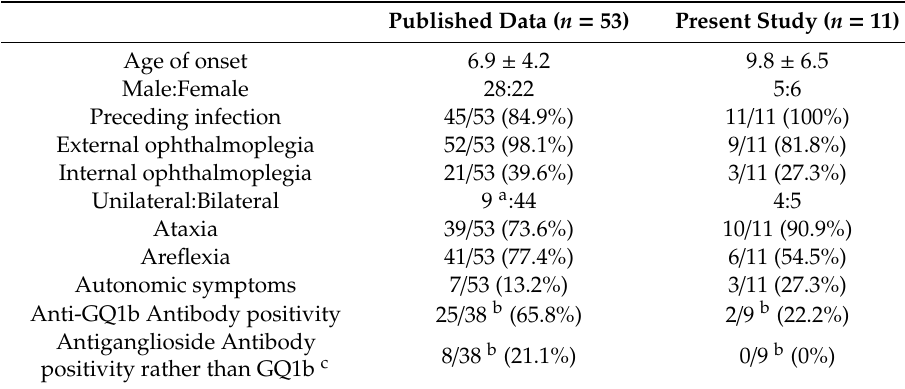
Table 3. Demographics of pediatric Miller Fisher syndrome in the literature, and its comparison with pediatric MFS in our